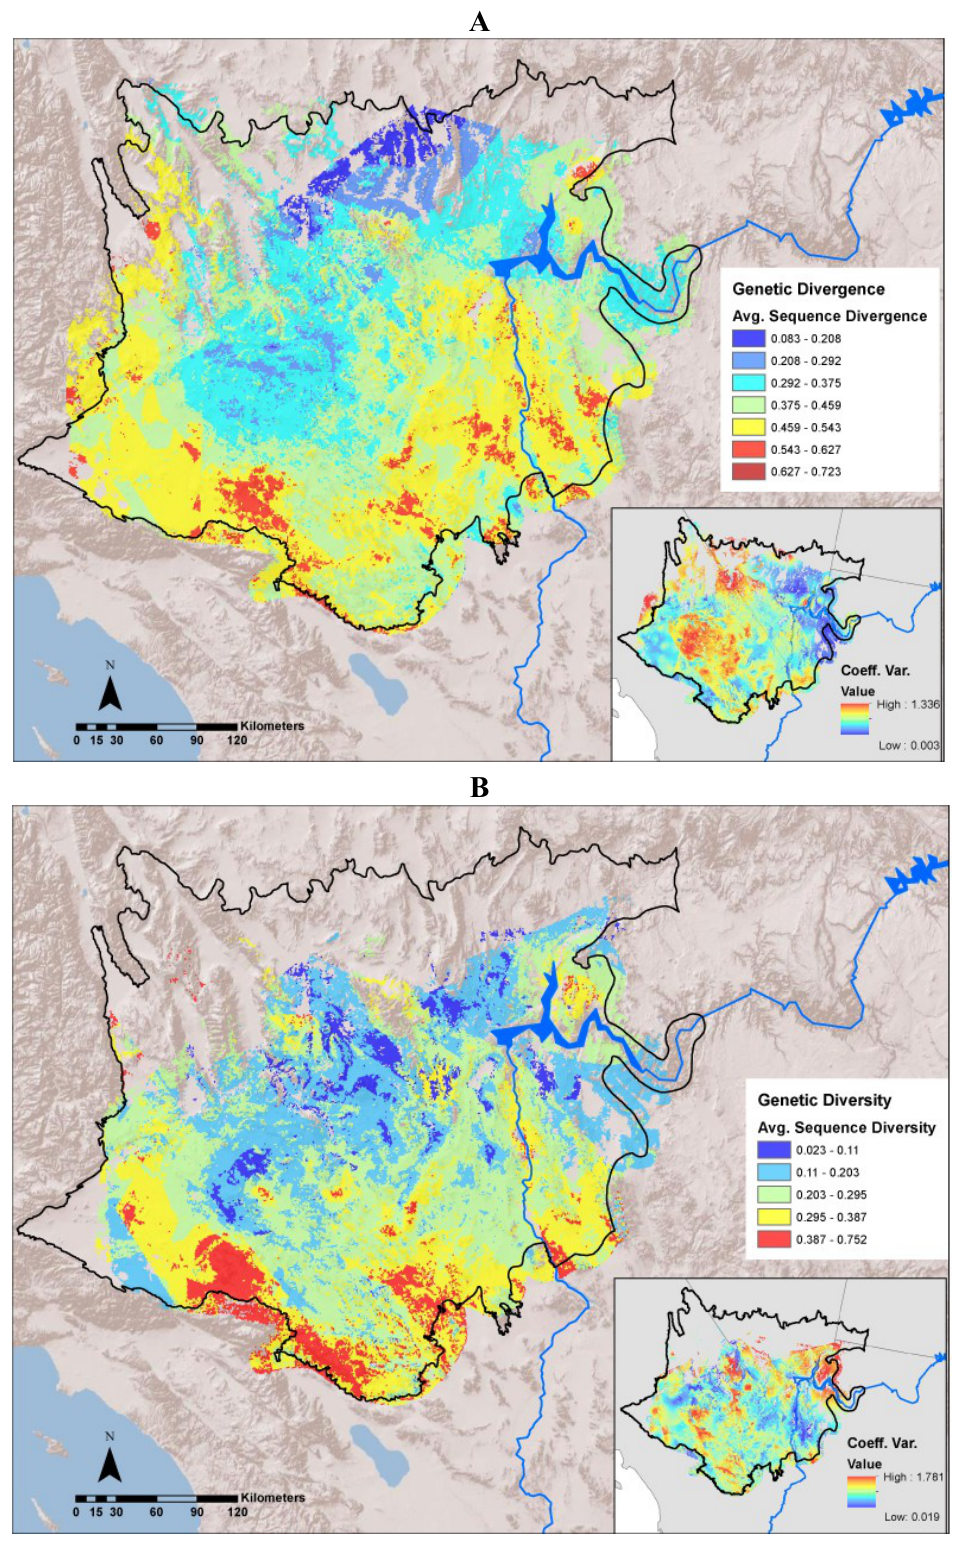
Figure 2. ( A ): Average sequence divergence for 17 animal species; ( B ): Average sequence diversity for 14 animal species; ( C ): Average gene diversity for 13 animal species. The insets in each figure show the coefficient of variation among individual species layers included in each average.